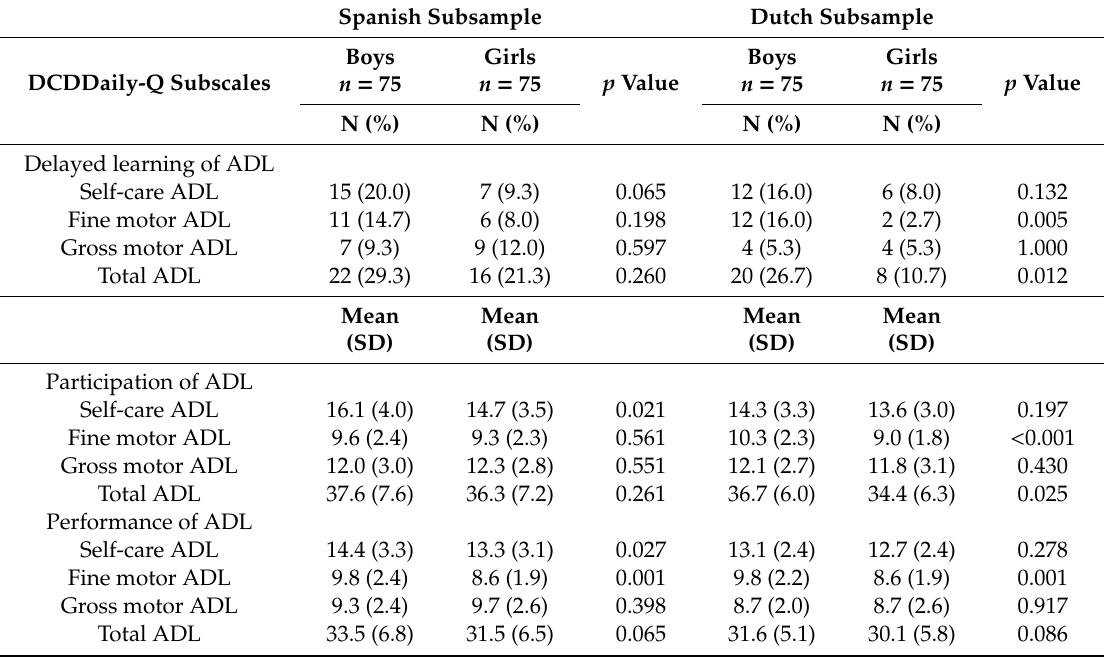
Table 2. Di ff erences in learning, participation and performance of ADL in boys and girls according to country ( n =